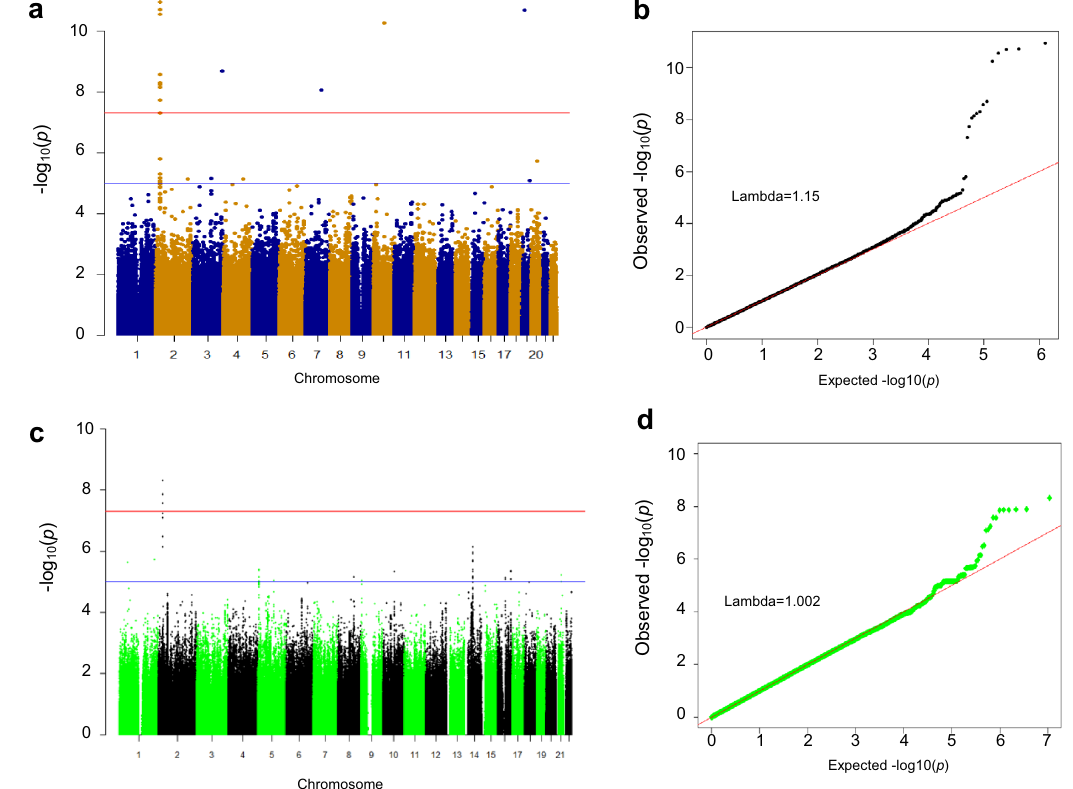
Fig. 3 GWAS of follistatin in the MDC-CC and SUMMIT-VIP cohort. a Manhattan plot ( − log 10 GWAS plot) of GWAS on plasma follistatin in individuals of MDC-CC cohort ( n = 4195). The most signi fi cant SNPs in this analysis are rs780094, rs780093, and rs1260326 in the GCKR gene (glucokinase regulatory protein). b Quantile-quantile (QQ) plot of the data shown in the Manhattan plot in a . c Manhattan plot ( − log 10 GWAS plot) of GWAS on plasma follistatin in individuals of SUMMIT cohort ( n = 885). The most signi fi cant SNP in this analysis is rs1260326 in the GCKR gene. d Quantile-quantile (QQ) plot of the data shown in the Manhattan plot in c . The genome-wide signi fi cance level is set at 5 × 10 − 8 and plotted as the dotted line.